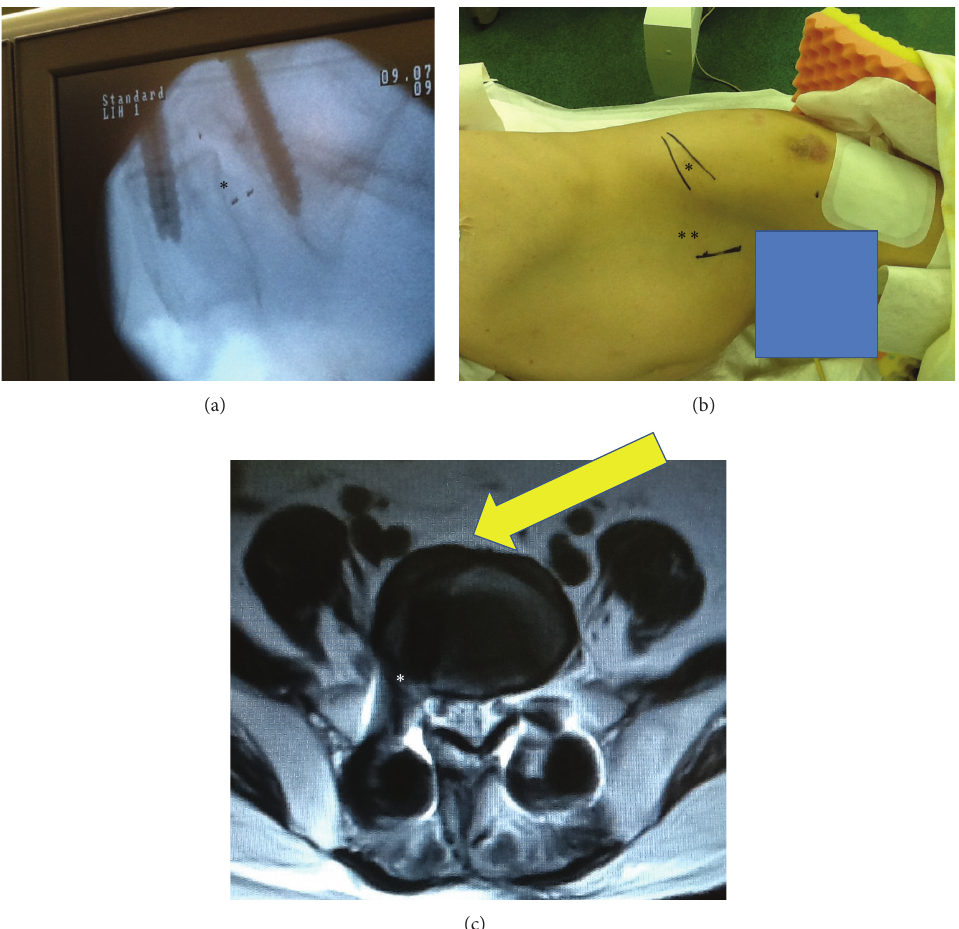
Figure 1: (a) Posterior movement of the TLIF cage 6 months after surgery ( ∗ ). (b) The patient was placed in a lateral decubitus position. ∗ Midportion of the L5-S1 disk. ∗∗ A 5cm skin incision was made 10 cm anterior from the midportion of the L5-S1 disk. (c) MRI showing right foraminal stenosis between L5 and S1 because of the cage. Arrow indicates the approach between major